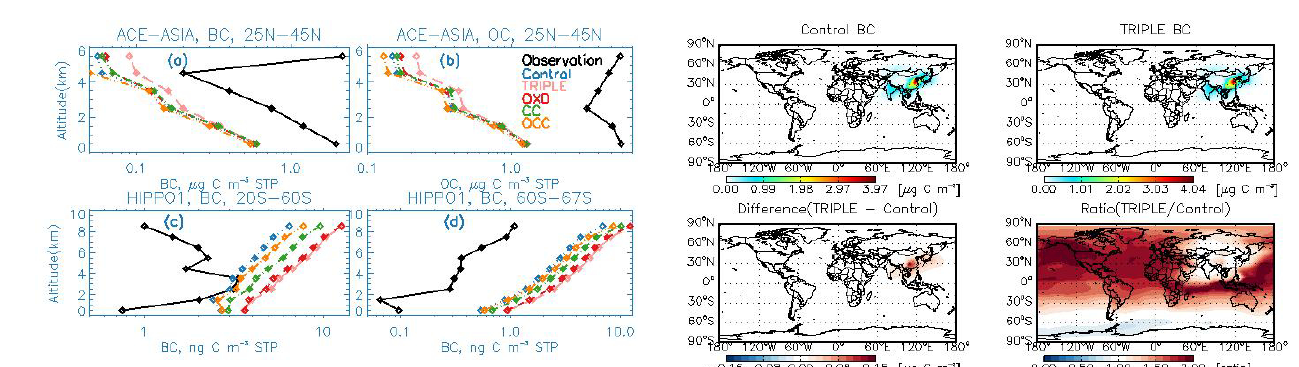
Fig. 11a. Impacts of the TRIPLE aging scheme on model calculated continental outflow of annual mean BC from Asia (the global BC emissions except those over Asia are turned off in the model sim- ulations). (Upper left) Surface BC concentrations from the control run; (upper right) surface BC concentrations from the sensitivity run with the TRIPLE aging scheme; (lower left) differences between the sensitivity run and control run; (lower right) ratio between the sen- sitivity run and control